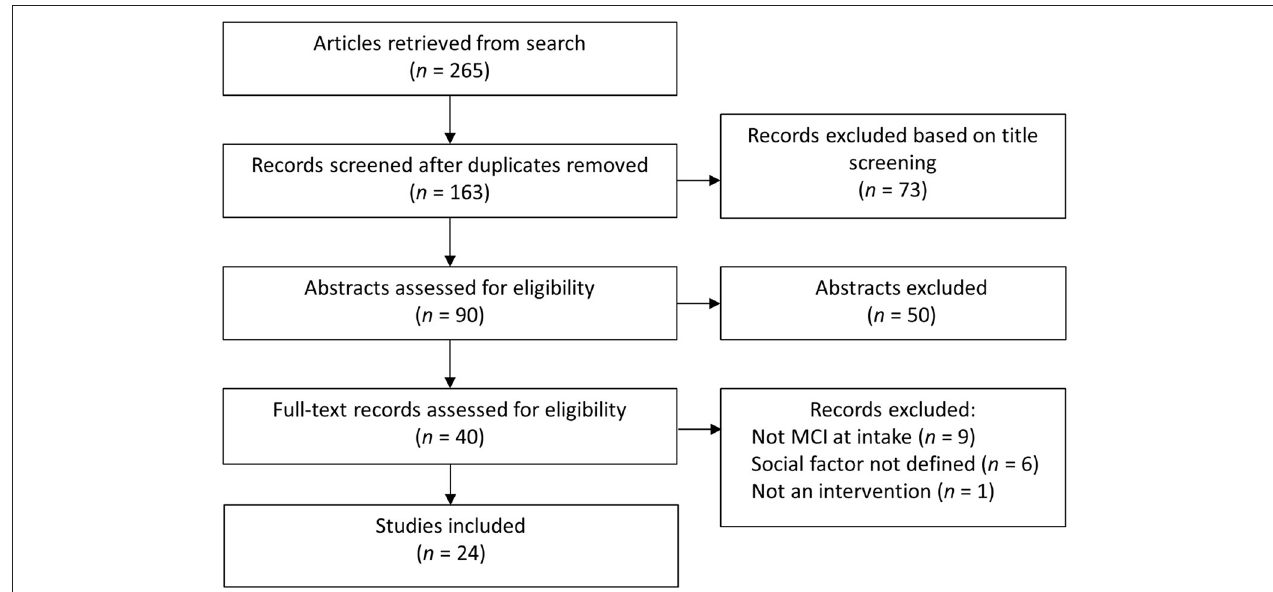
FIGURE 2 | Overview of article